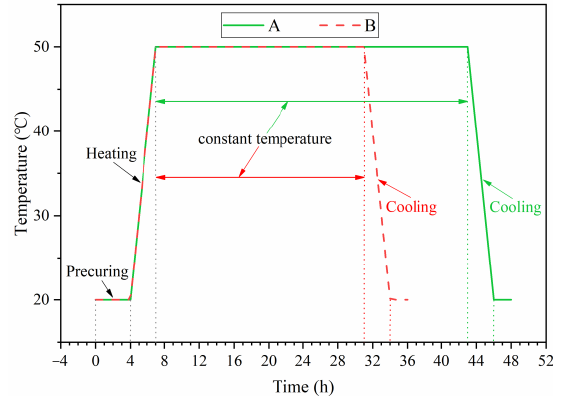
Figure 4. Steam curing regime.